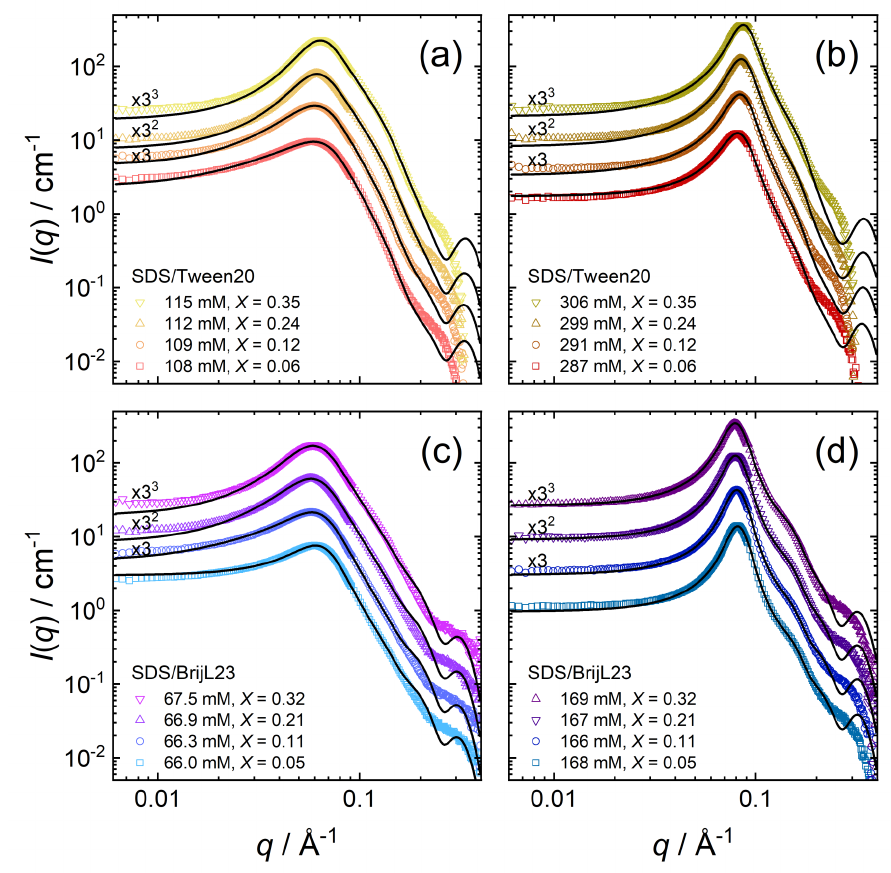
Figure 6. SANS data for surfactant mixtures at varying mixing ratios X =[SDS]/([SDS]+[nonionic]): ( a , b ) SDS/Tween20, and ( c , d ) SDS/BrijL23. Symbols are experimental scattering data. The black solid lines are model fits to the data by Equation (1). Data sets are scaled by the factors in black for clarity.